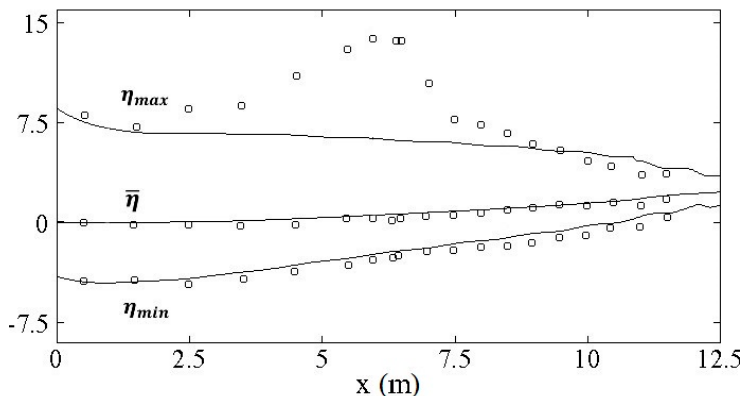
Figure 5. Ting and Kirby [21] spilling breaking wave test case. Mean water level and distribution of phase-averaged crest and trough elevations along the cross-shore direction. Comparison between experimental data (empty circles) and numerical model in which the turbulence model is the standard k − ε proposed by Rodi [23] (solid line).